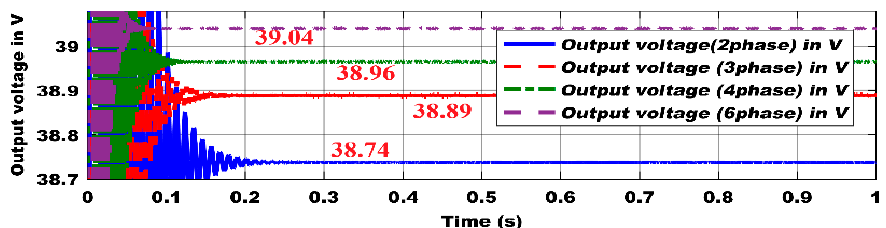
Figure 2. Output voltage comparison of MPIBC at duty cycle of 50%.